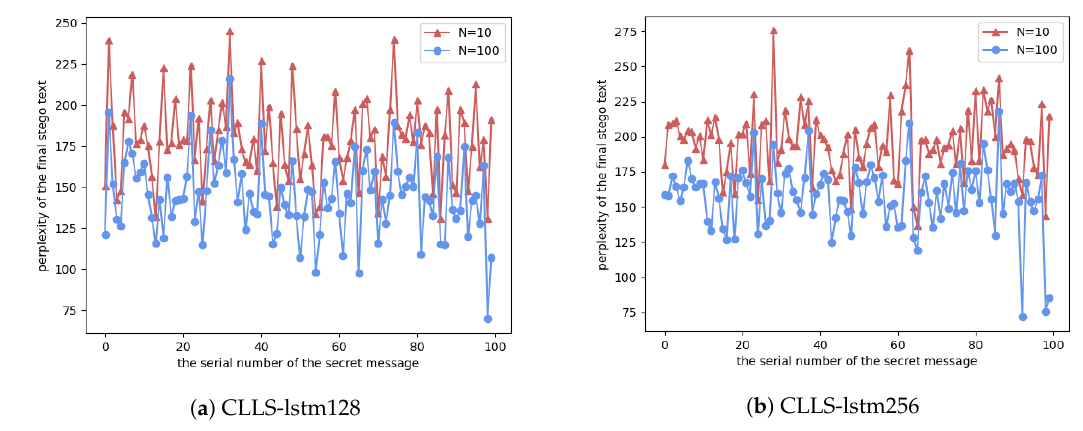
Figure 4. Comparison of the perplexity values of the stego texts.